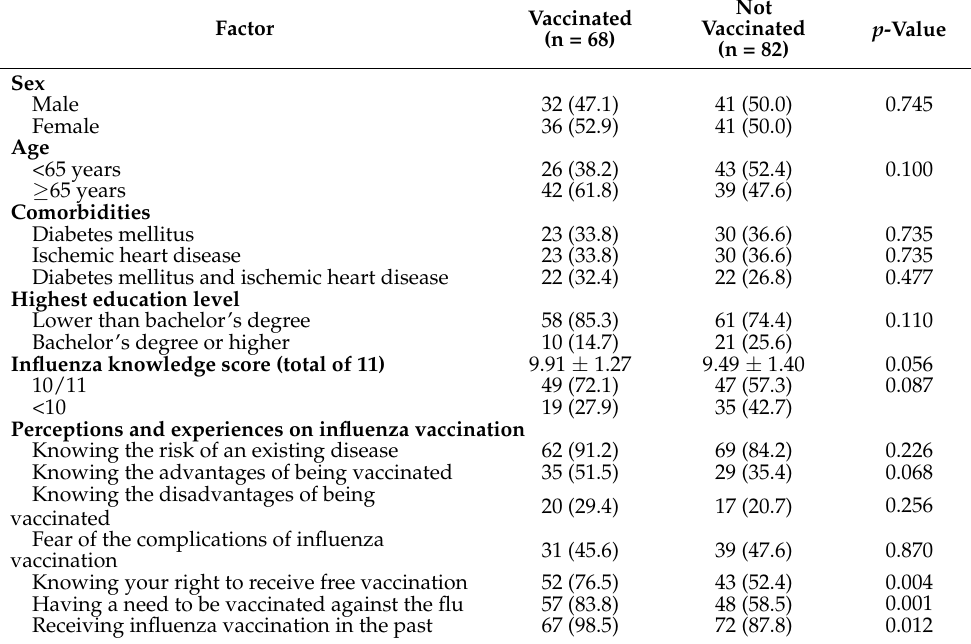
Table 1. Patients’ characteristics by influenza vaccination status (n =